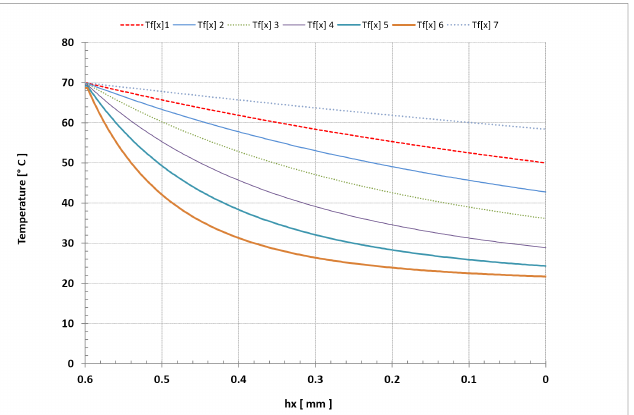
Figure 17. Iron Element Radiator T1 type —water temperature distribution according simulation calculations , t s = 89.7 ◦ C, mass flow q mx from 24% to 153% nominal